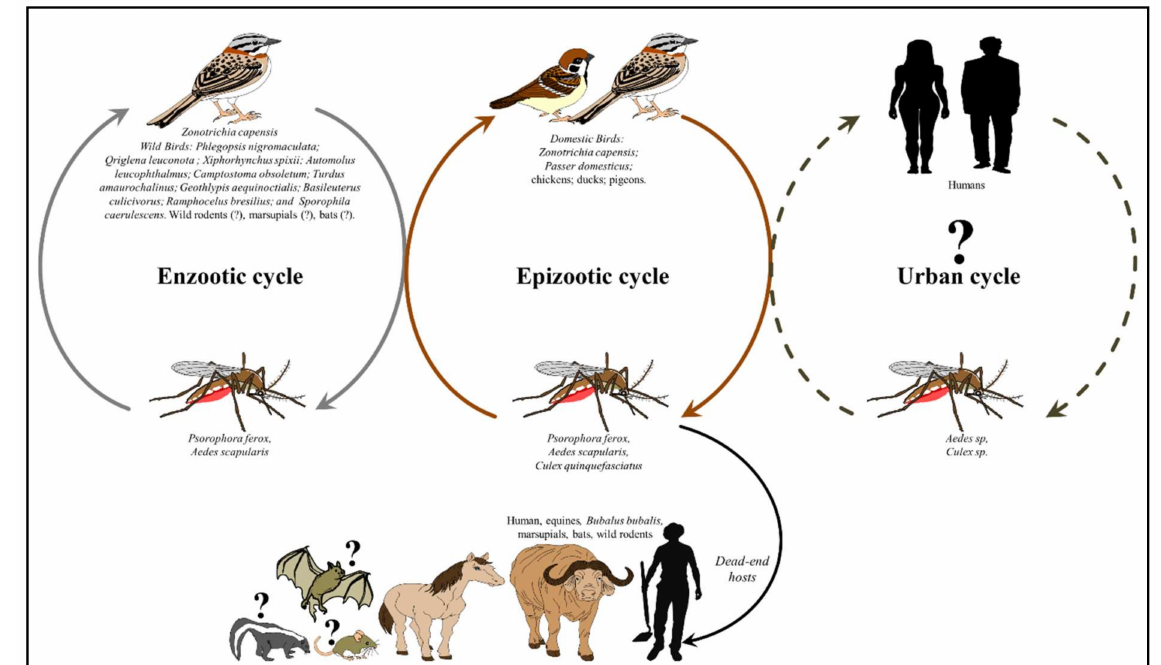
Figure 2. The transmission cycles of